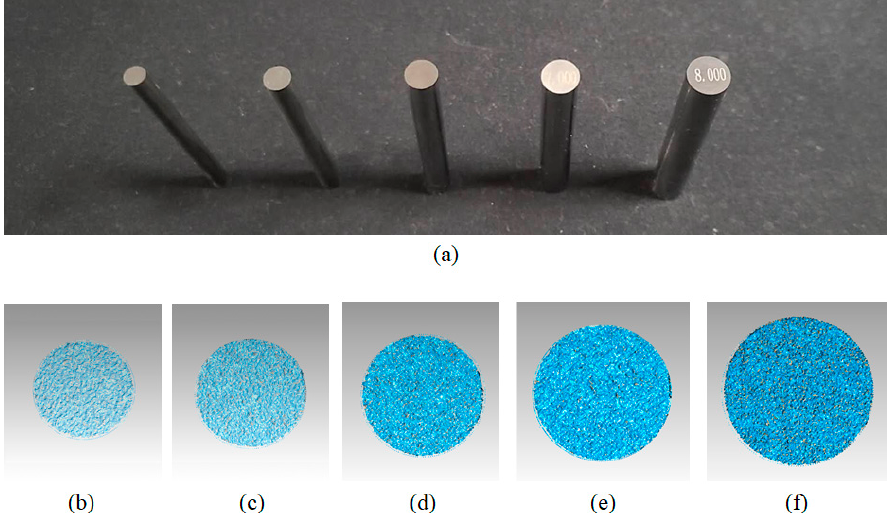
Figure 9. Experimental results on standard objects. ( a ) demonstrates the cylinder standards. ( b – f ) illustrate the measured 3-D data of the end surface: ( b ) 4.000 mm, ( c ) 5.000 mm, ( d ), 6.000 mm, ( e ) 7.000 mm, ( f ) 8.000 mm.